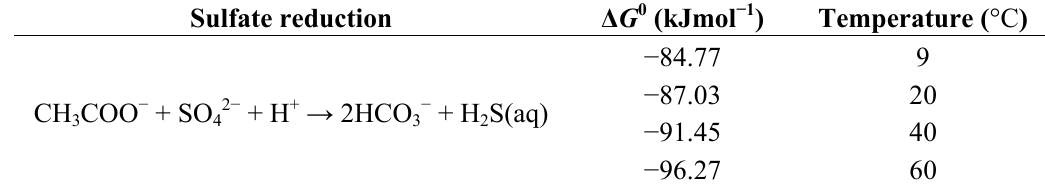
Table 2. Chemical reactions and associated standard free energy change Δ G 0 for sulfate reduction, calculated using CH COO − as electron donor in terms of the transfer of 3 eight